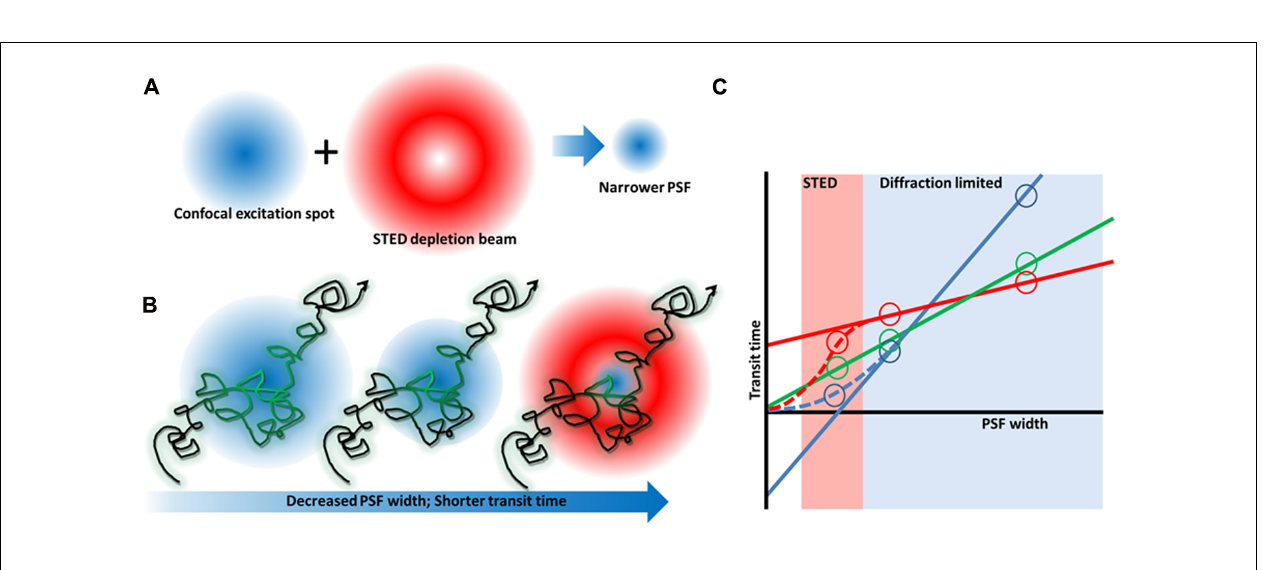
FIGURE 1 | Photoactivated localization microscopy analysis of protein clustering at the cell surface. Photo-activation or stable dark states of fluorophores are exploited to limit the number of fluorescent molecules in each image frame. The fluorescence of individual molecules are captured with a camera and the center of the point-spread function (PSF) calculated to localize the molecules with nanometer precision. During the imaging processes, the fluorescence molecules are bleached so that the combination of photo-activation and photo-bleaching gives